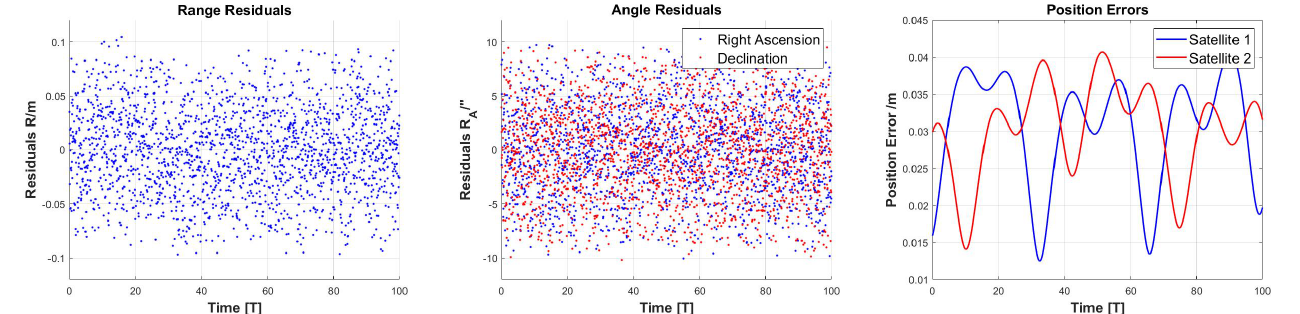
Figure 9. Residual in the range data ( left ), residual in the angle data ( middle ) and norm of the position error of the determined orbit from the true one ( right ) (test 6).